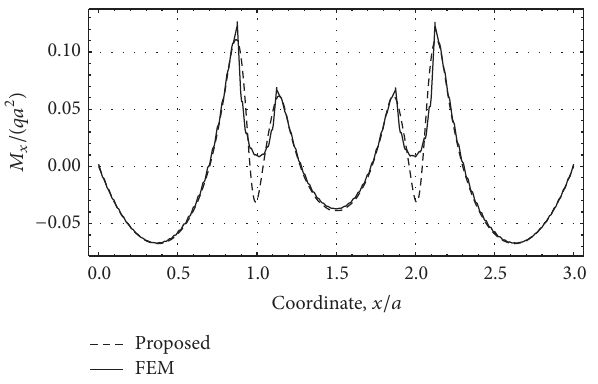
Figure 10: Bending moment 𝑀 𝑥 at 𝑦 = 𝑎 .